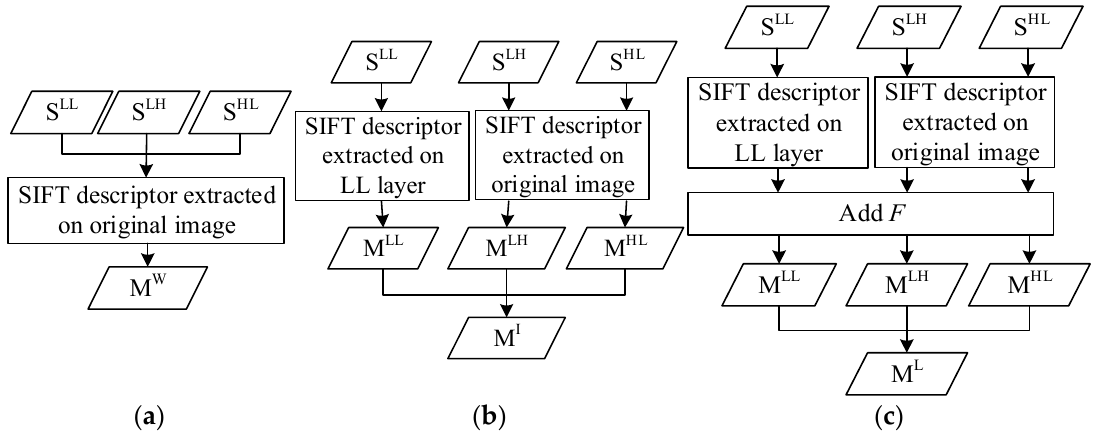
Figure 3. Feature set constructing process of ( a ) WWF, ( b ) IWWF, and ( c ) LIWWF.